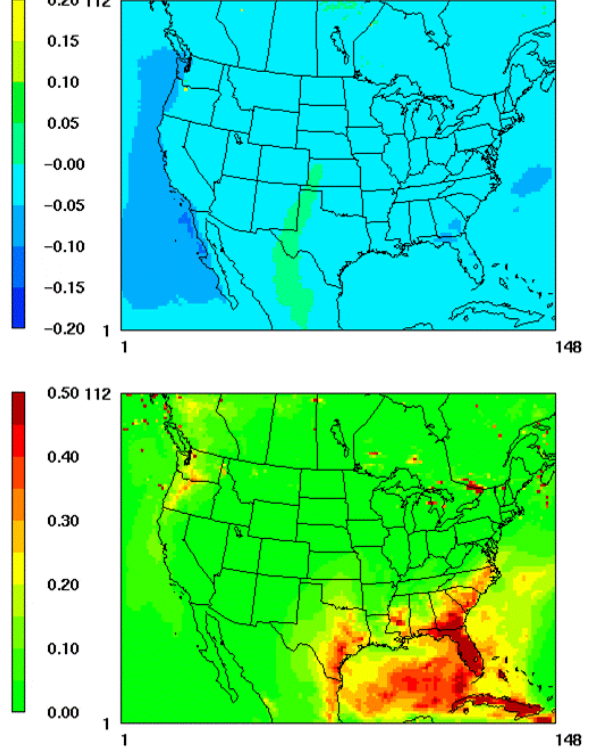
Fig. 10. Average relative changes ( ) for June in surface layer SO 2 mixing ratio (top) and sulfate Fig. 10. Average relative changes ( 1 ) for June in surface layer SO 2 concentration (bottom) incurred by increasing the fraction of sulfate radical formed from aqueous SO 2 Fig. 9. Average relative changes ( ) for June in surface layer SO 2 mixing ratio (top) and sulfate Fig. 9. Average relative changes ( 1 ) for June in surface layer SO 2 mixing ratio (top) and sulfate concentration (bottom) incurred by and H 2 SO 4 in clouds (i.e., test F). The reference case is test E results. concentration (bottom) incurred by enhancing cloud cover over the Pacific Ocean portion of the mixing ratio (top) and sulfate concentration (bottom) incurred by increasing the fraction of sulfate radical formed from aqueous SO 2 modeling domain (i.e., test E). The reference case is test C. enhancing cloud cover over the Pacific Ocean portion of the model- and H 2 SO 4 in clouds (i.e., test F). The reference case is test E re- ing domain (i.e., test E). The reference case is test C.